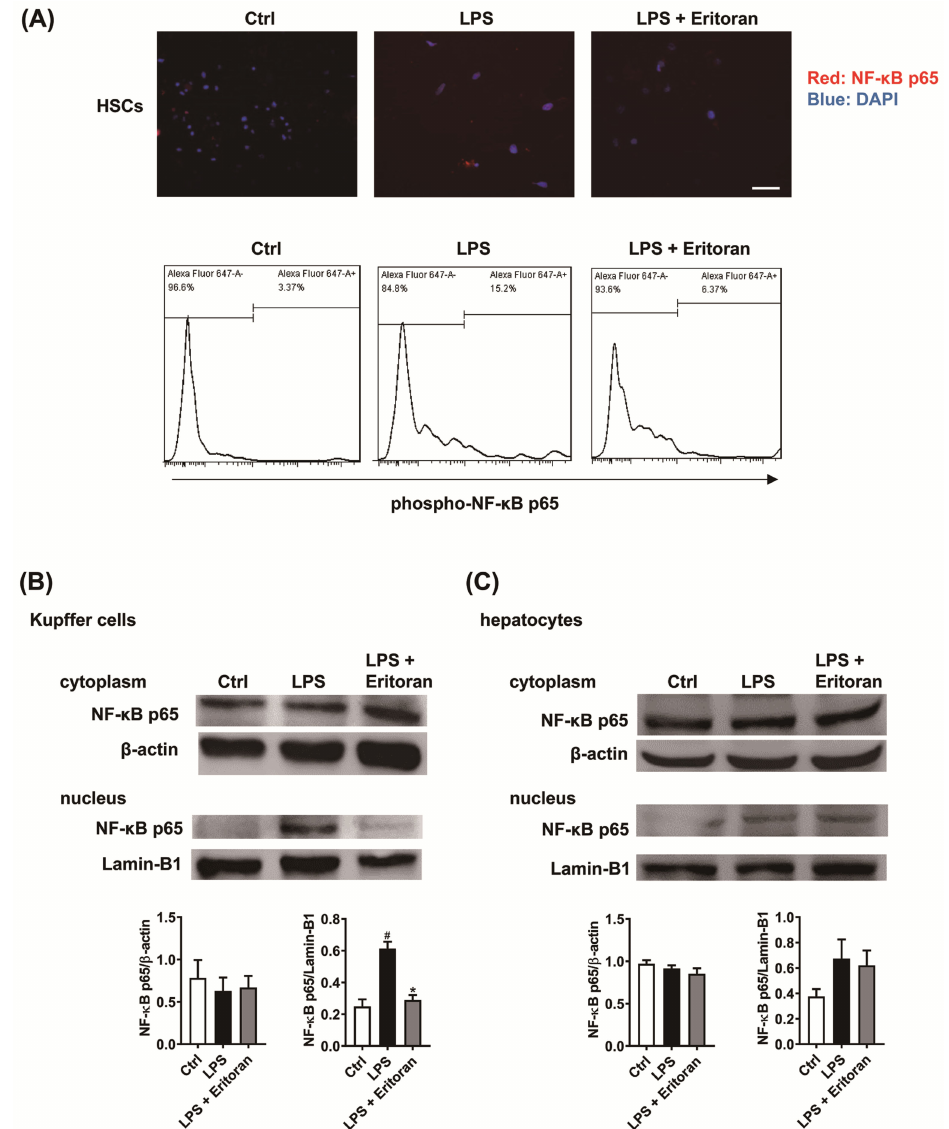
Figure 10. Eritoran suppressed the LPS-induced nuclear translocation of NF- κ B p65 in primary hepatic stellate cells (HSCs) and Kupffer cells (KCs). ( A ) Immunofluorescence staining of primary mouse HSCs treated with the control medium (Ctrl), lipopolysaccharide (LPS, 100 ng/mL) or LPS (100 ng/mL) + eritoran (10 µ g/mL) for 24 h. NF- κ B p65, red; DAPI (diamidino-2-phenylindole) nuclear stain, blue. Scale bar = 50 µ m. Flow cytometric analysis of the phosphorylated NF- κ B p65 expression in primary HSCs. ( B ) Cytoplasmic and nuclear NF- κ B p65 of primary KCs treated with the Ctrl, LPS (100 ng/mL) or LPS (100 ng/mL) + eritoran (10 µ g/mL) for 24 h ( n = 4/group). ( C ) Cytoplasmic and nuclear NF- κ B p65 of primary hepatocytes treated with the Ctrl, LPS (1 µ g/mL) or LPS (1 µ g/mL) + eritoran (10 µ g/mL) for 24 h ( n = 4/group); # p < 0.05 vs. the Ctrl group; * p < 0.05 vs. the LPS